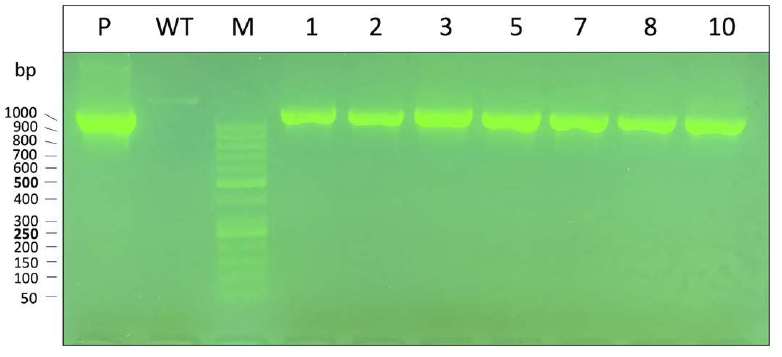
Figure 8. Check on agarose gel of PCR products of obtained clones cultured in absence of Hygromycin selection antibiotic; we amplified pcDNA3.1Hygro(+)-α-globin (P) as a positive control and K562 DNA as a negative control. Marker (M) graduation is displayed at the left of the gel image.